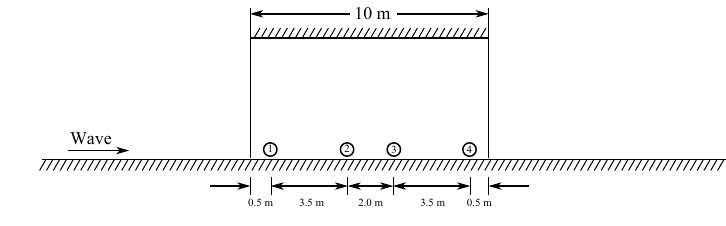
Figure 6. Wiggert experimental setup.